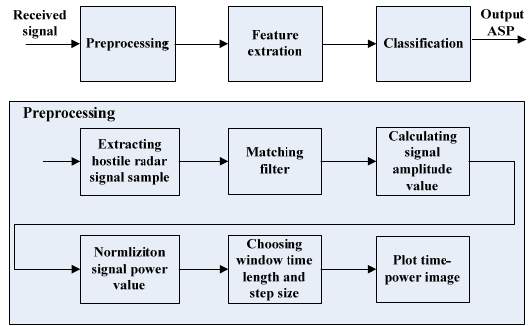
Figure 6. The block diagram of the proposed method.